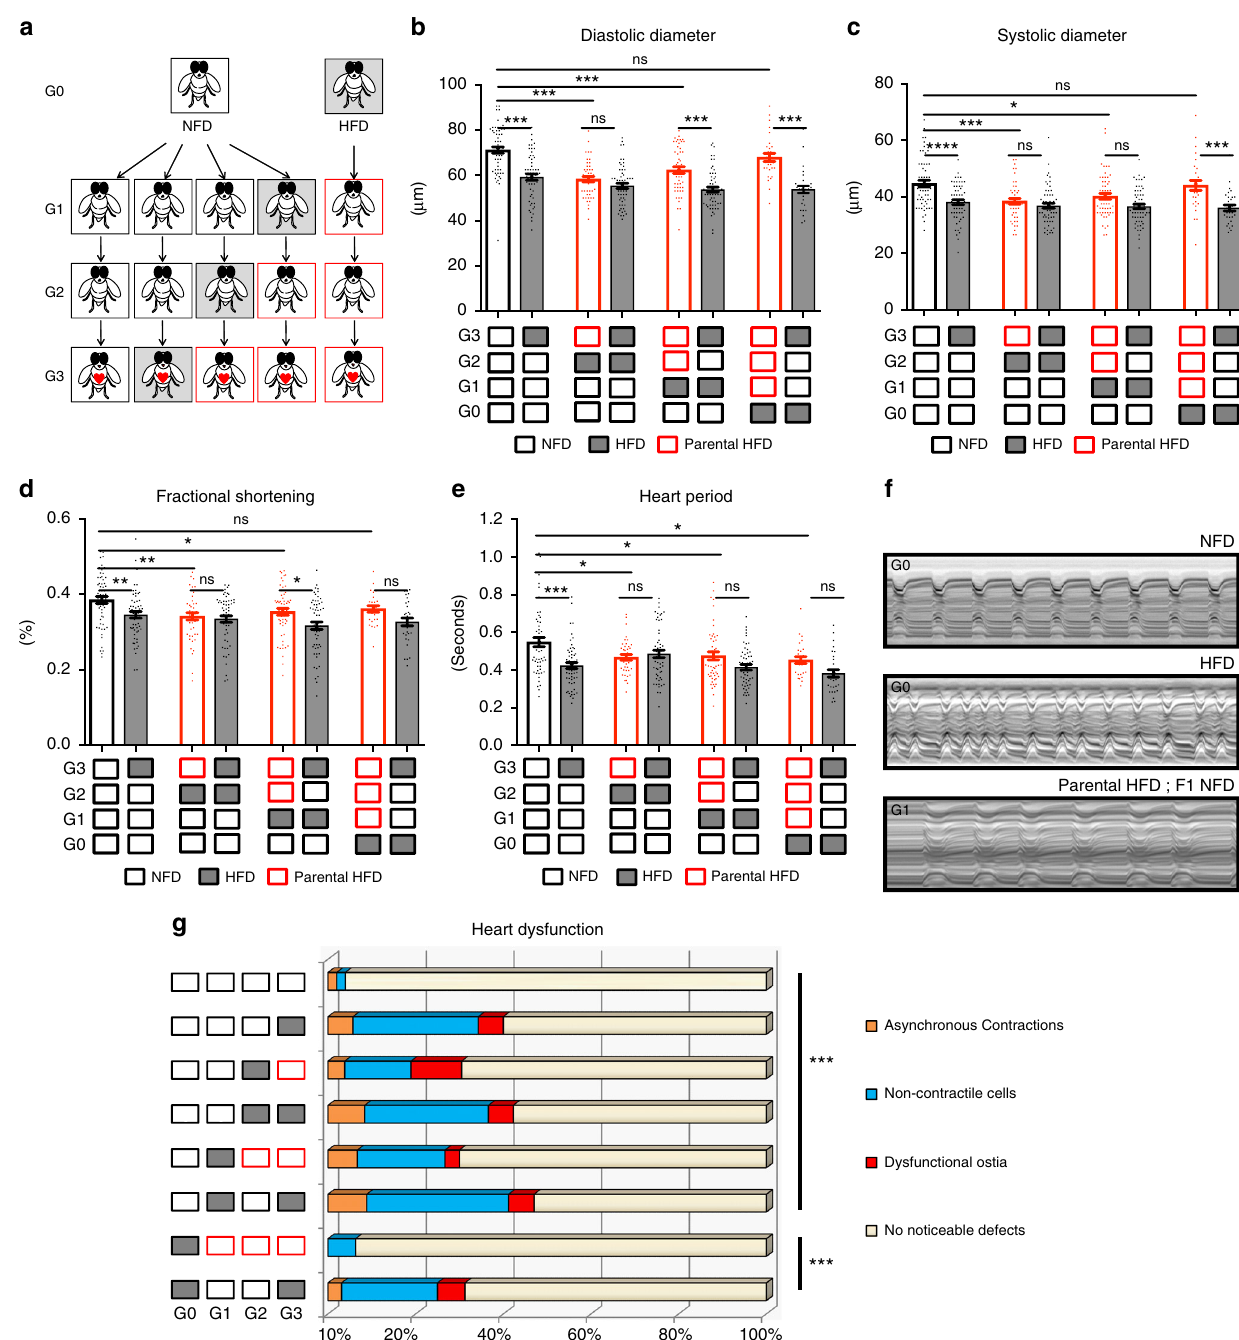
Fig. 1 Parental HFD exposure causes intergenerational heart dysfunction. a Diagram with generation of control fl ies ( w 1118 ) fed a normal food diet (NFD; open boxes) or a high-fat diet (HFD; gray boxes). Boxes outlined in red highlight the generations on NFD after the original exposure to a HFD, and correspond to the bars with red outline in all bar charts (parental HFD). Flies with red hearts indicate the experimental fl ies tested for changes in heart function b – g TAG levels (Fig. 2c) and bmm transcript levels (Fig. 2g). Note that only mated female adults were analyzed in this study. Diastolic diameters ( b ) systolic diameters ( c ), fractional shortening ( d ) and heart period ( e ) were measured in G3 adult fl ies ( n = 25 – 55 fl ies pooled from at least